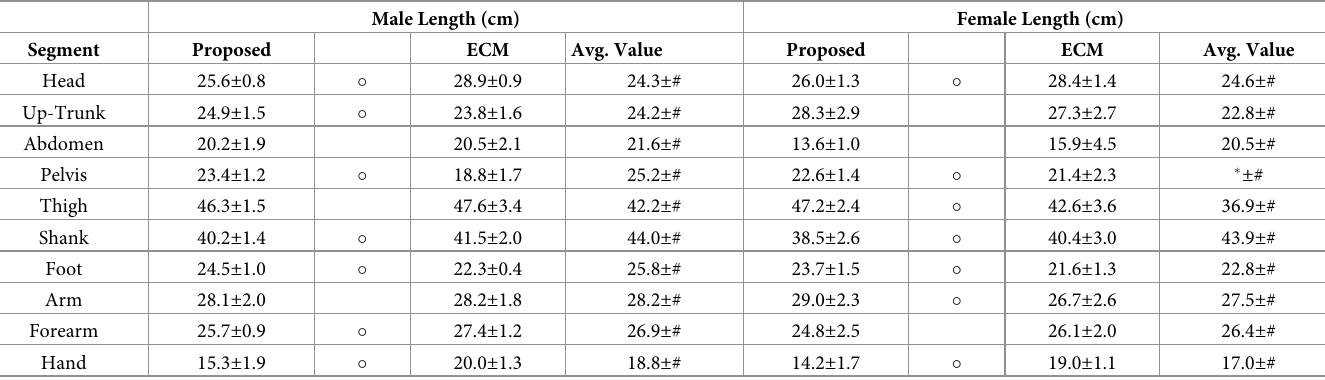
Table 5. Longitudinal length estimates (mean ± SD in cm) obtained using the proposed method and the ECM approach for both male and female participants. Male Length (cm) Female Length (cm) Segment